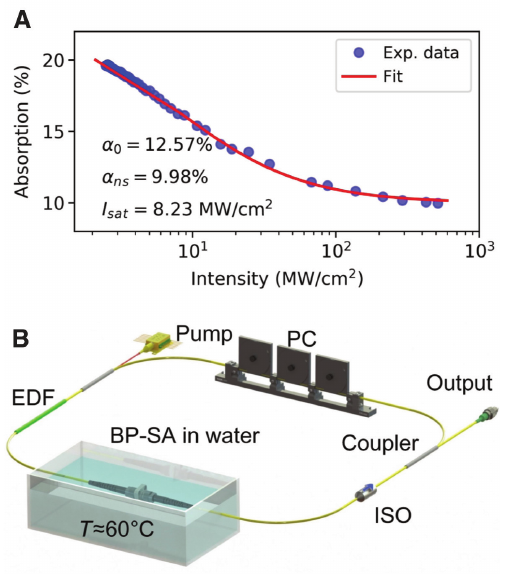
Figure 1: Nonlinear optical response of BP-SA and the schematic of the